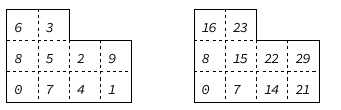
Fig. 3: Two different types of minimum distances diagrams for the set A